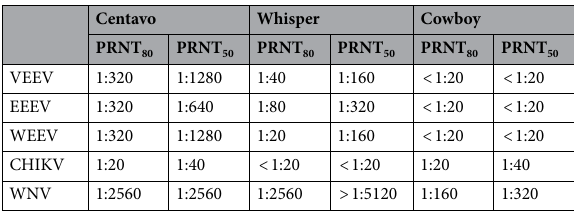
Table 1. Neutralization of viruses by llama